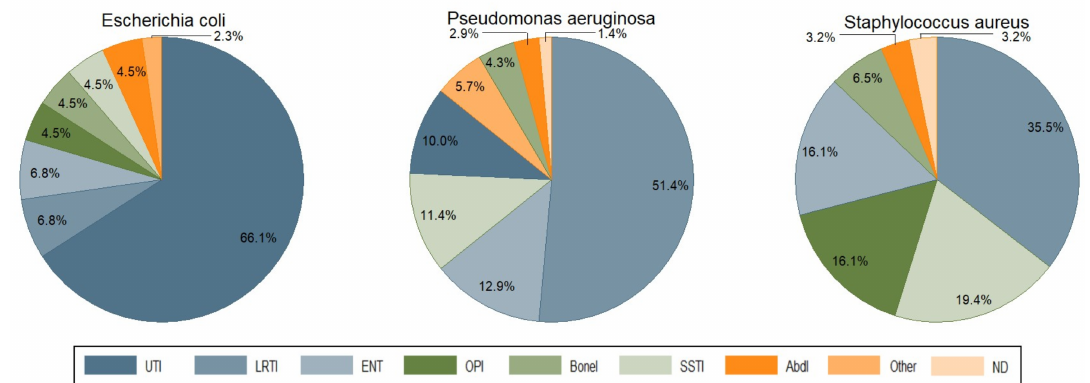
Figure 4. The proportion of the three most prevalent bacteria in the different infection types. AbdI, abdominal infection; BoneI, bone infection; ENT, ear-nose-throat; LRTI, lower respiratory tract infection; OPI, Orthopedic prosthesis infection; SSTI, skin and soft tissue infection; UTI, urinary tract infection.